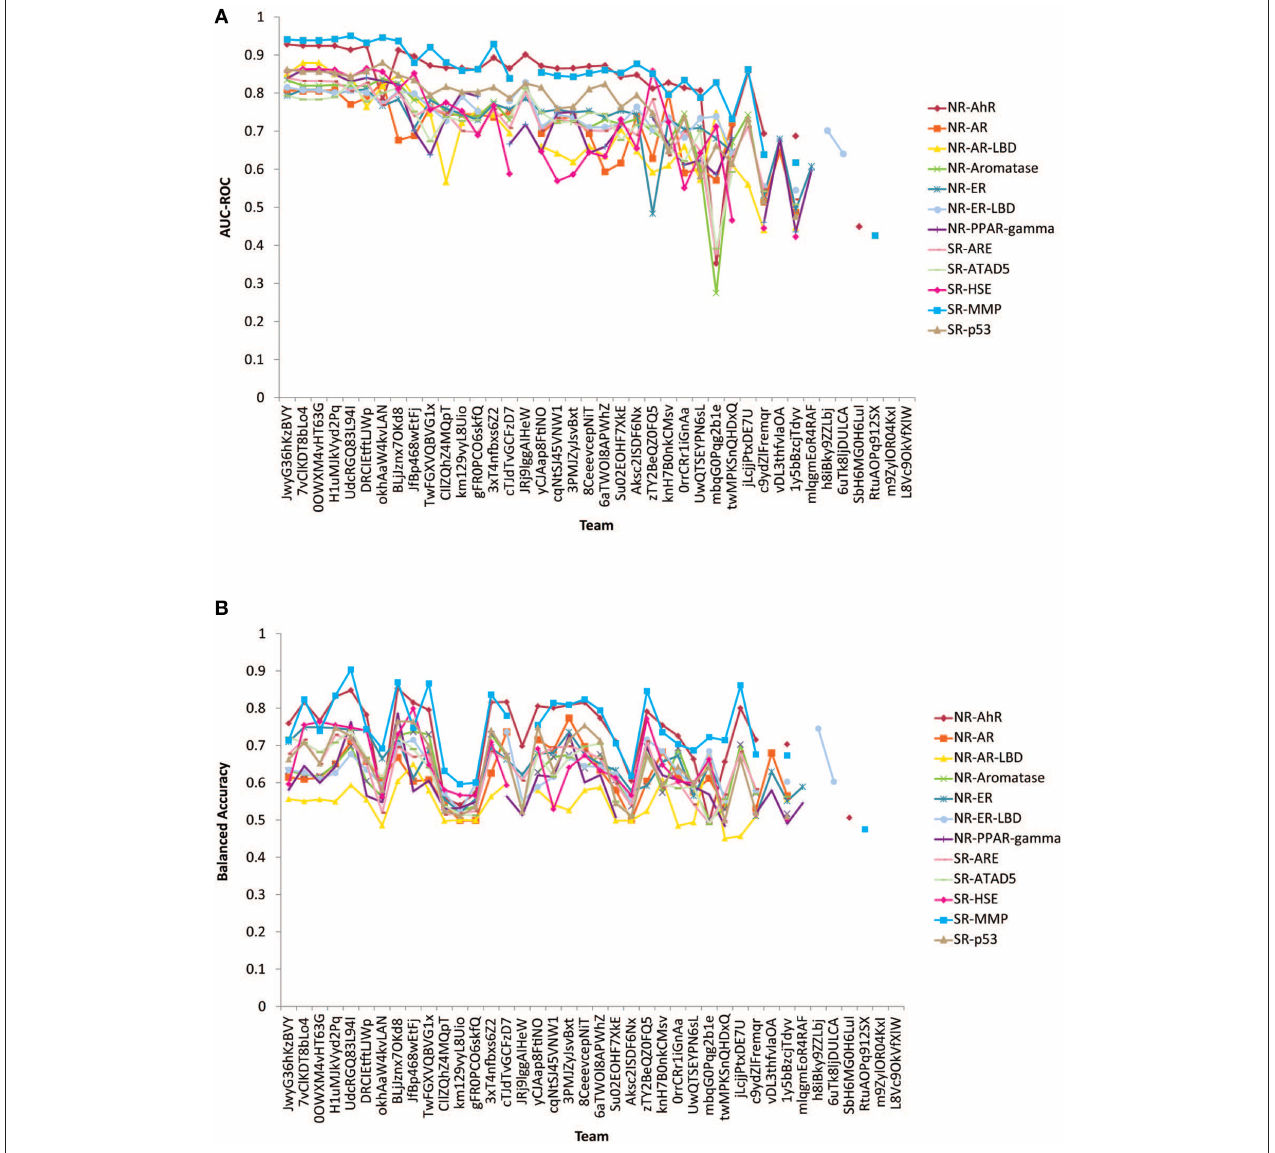
FIGURE 2 | Performances of models received for the 12 subchallenges for final evaluation. (A) Measured by AUC-ROC (B) Measured by balanced